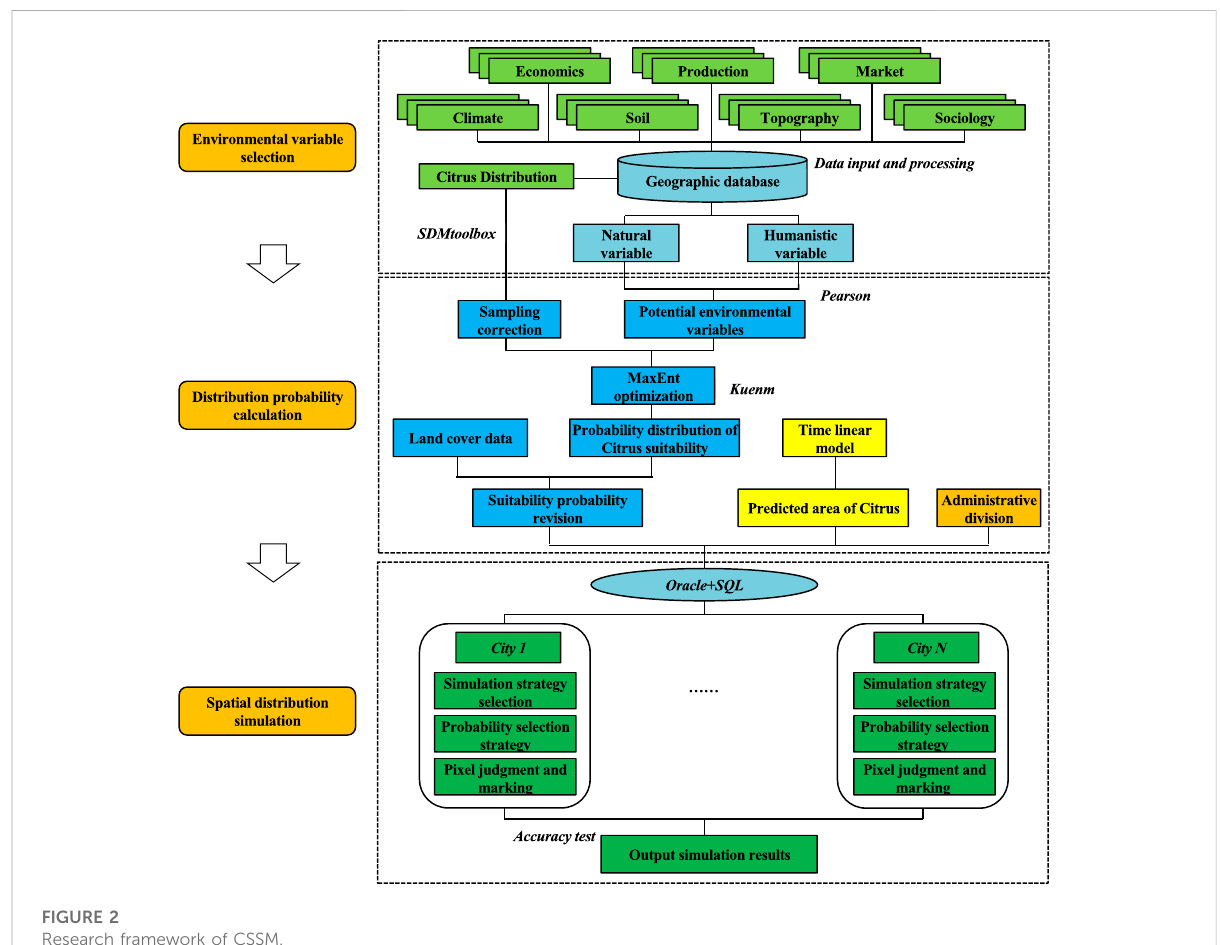
FIGURE 2 Research framework of